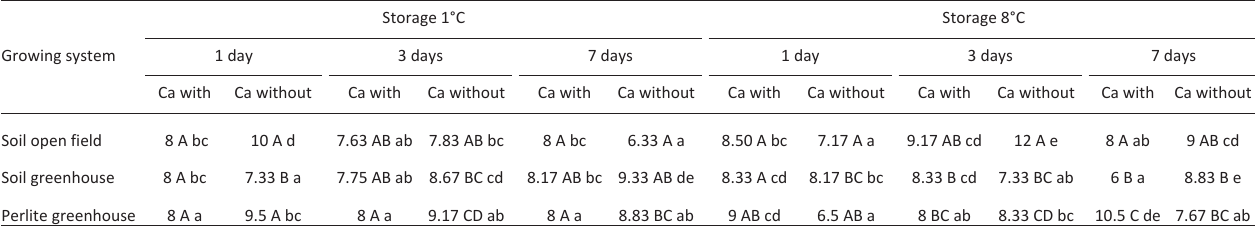
Different capital letters indicate differences between row and different small letters indicate differences between columns